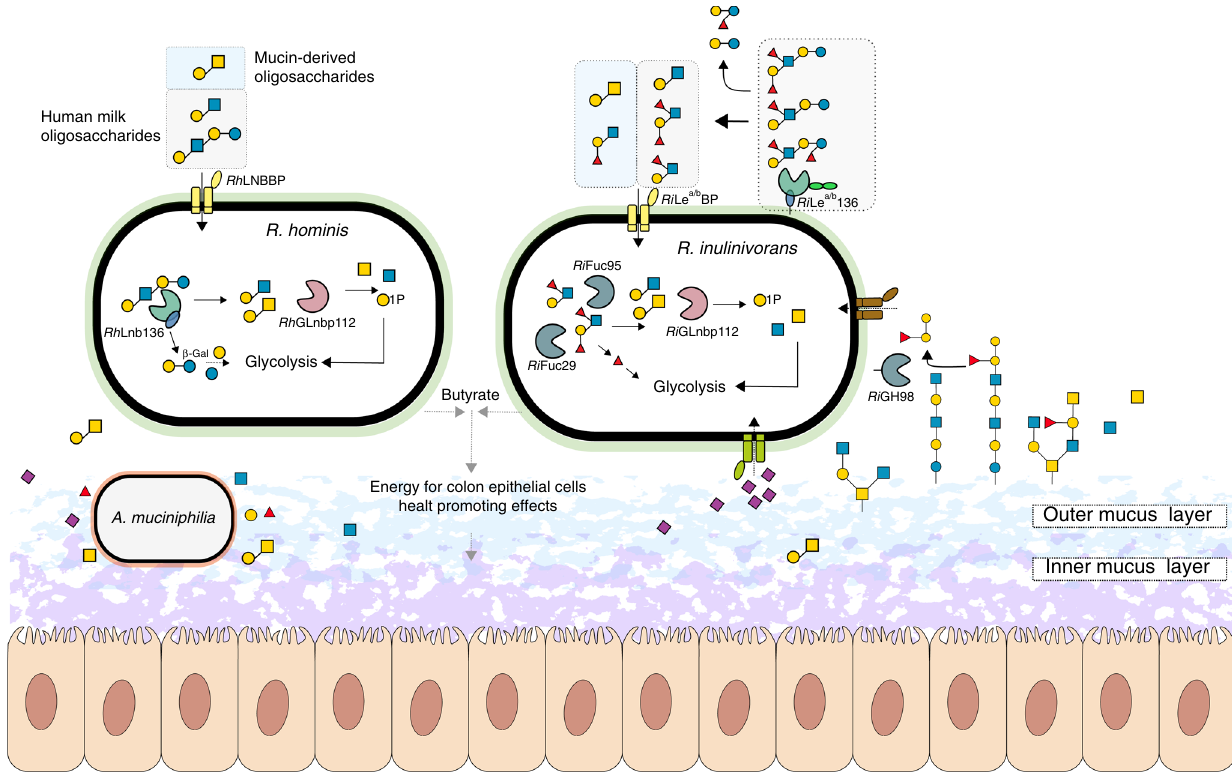
Fig. 6 Model for HMOs and related host glycan utilization by Roseburia and other Lachnospiraceae. In R. hominis , LNT, LNB and the mucin derived GNB are captured by Rh LNBBP for uptake into the cytoplasm and LNT is subsequently hydrolysed to LNB. Both LNB and GNB are phosphorolyzed by Rh GLnbp112 into α - D -galactose-1-phosphate and the corresponding N -acetylhexosamines GlcNAc and GalNAc, respectively. Lactose is likely hydrolysed by a canonical β -galactosidase. In R. inulinivorans , initial hydrolysis of HMOs or O -glycans from glyco-lipids/proteins occurs at the outer cell surface by Ri Le a/b 136, which has two C-terminal putative galactose-binding domains. The import of degradation products is mediated by the Ri Le a/b BP-associated ABC transporter. Fucosyl decorations are removed by the concerted activity of Ri Fuc95 and Ri Fuc29 before Rh GLnbp112 phosphorolyzes the resulting LNB or imported GNB into monosaccharides, as described in R. hominis . Galactose and galactose-1-phosphate products are converted via the Leloir pathway to glucose-6- phosphate and N -acetylhexosamine sugars are converted to GlcNAc-6-phosphate before entering glycolysis. The pyruvate generated from glycolysis is partly converted to butyrate 46 . Roseburia inhabits the outer mucus layer 47 together with A. muciniphilia . R. inulinivorans cross-feeds on sialic acid and accesses β -(1 → 4)-linked blood group A and B oligosaccharides from mucin and glyco- lipids/proteins via Ri GH98. Black solid arrows show enzymatic steps established or con fi rmed in this study. Black dotted arrows indicate steps based on literature. Grey dotted arrows indicate butyrate production by R. hominis and R. inulinivorans from mucin in co-culture with A. muciniphilia . The glycan structure key is the same as in Fig.